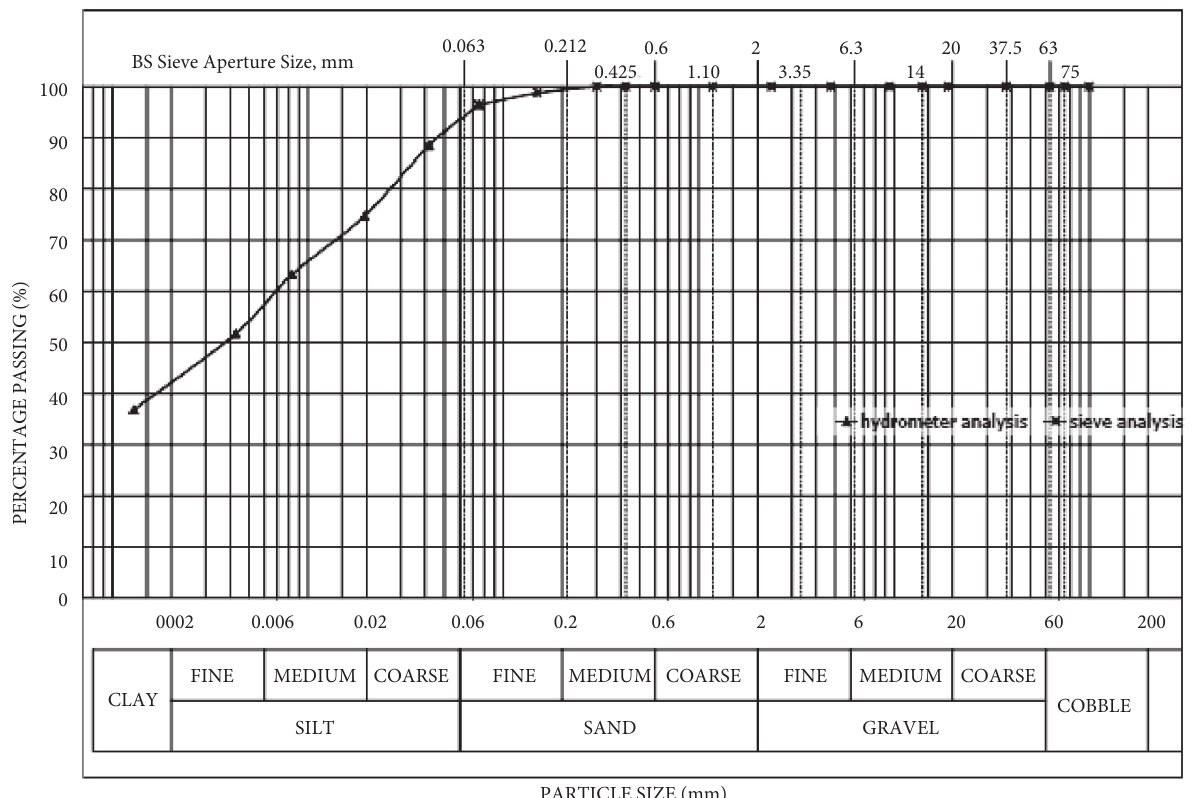
Figure 3: The particle size distribution of the sampled shale.